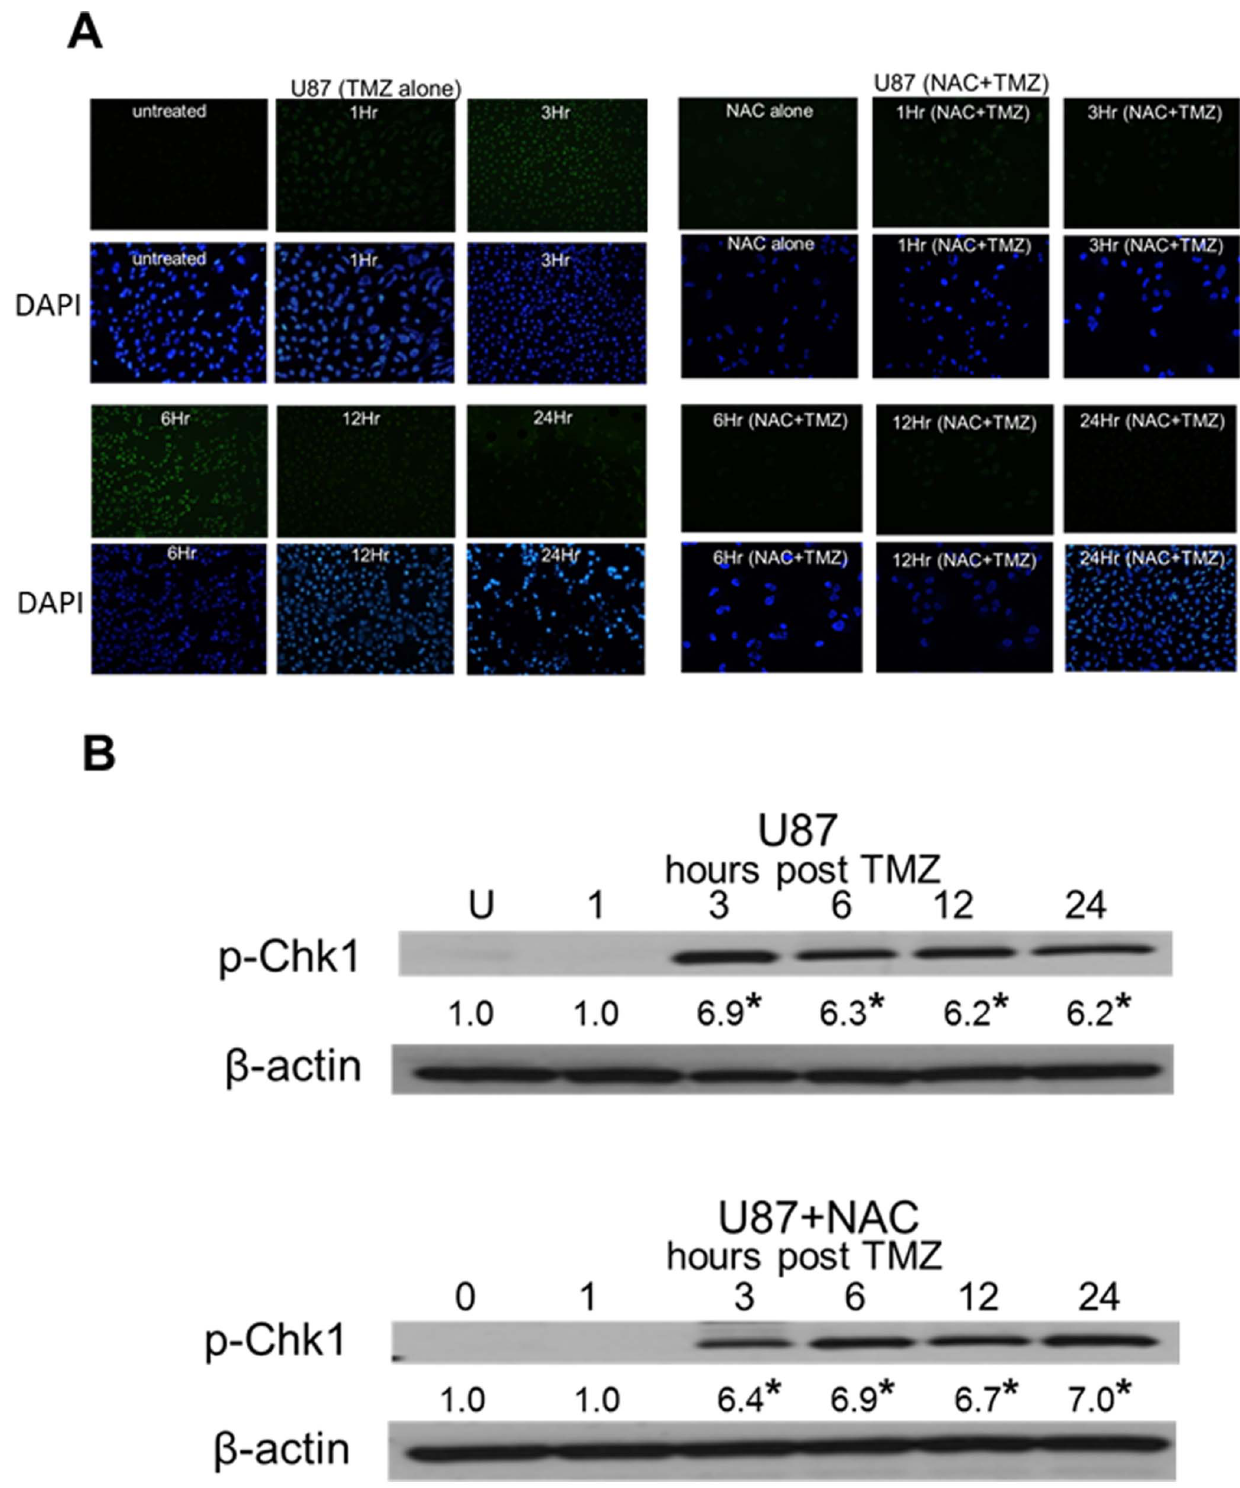
Figure 4. TMZ-induced Chk1 activation is independent of the TMZ-induced generation of ROS. MGMT-deficient U87 cells were pre- incubated with vehicle or the ROS scavenger NAC (400 m M, 2 hours) after which the cells were incubated with vehicle (untreated, U) or TMZ (100 m mol/L, 3 hours). TMZ was removed, vehicle or NAC was added, and the cells were harvested 1–24 hours following TMZ exposure for analysis of ROS based on the oxidation of 2,7-dichloro-dihydrofluorescein diacetate to an intracellular fluorescent compound (A, DAPI-stained cells as indicated), or pChk1 and b -actin expression by Western blot (B). Mean fold induction of protein expression was based on densitometric measurements and is shown (relative to untreated controls) below the relevant immunoreactive bands. *, p , .05.